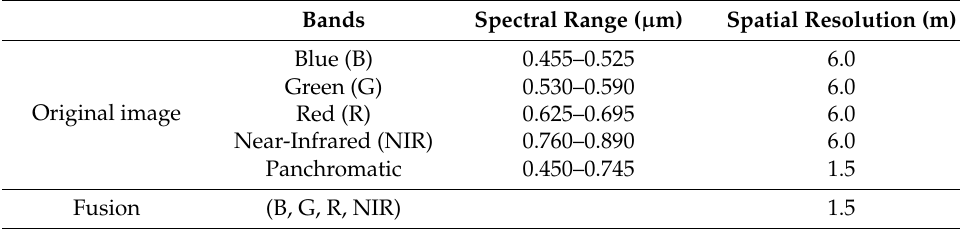
Table 1. Specification of SPOT 7 dataset.